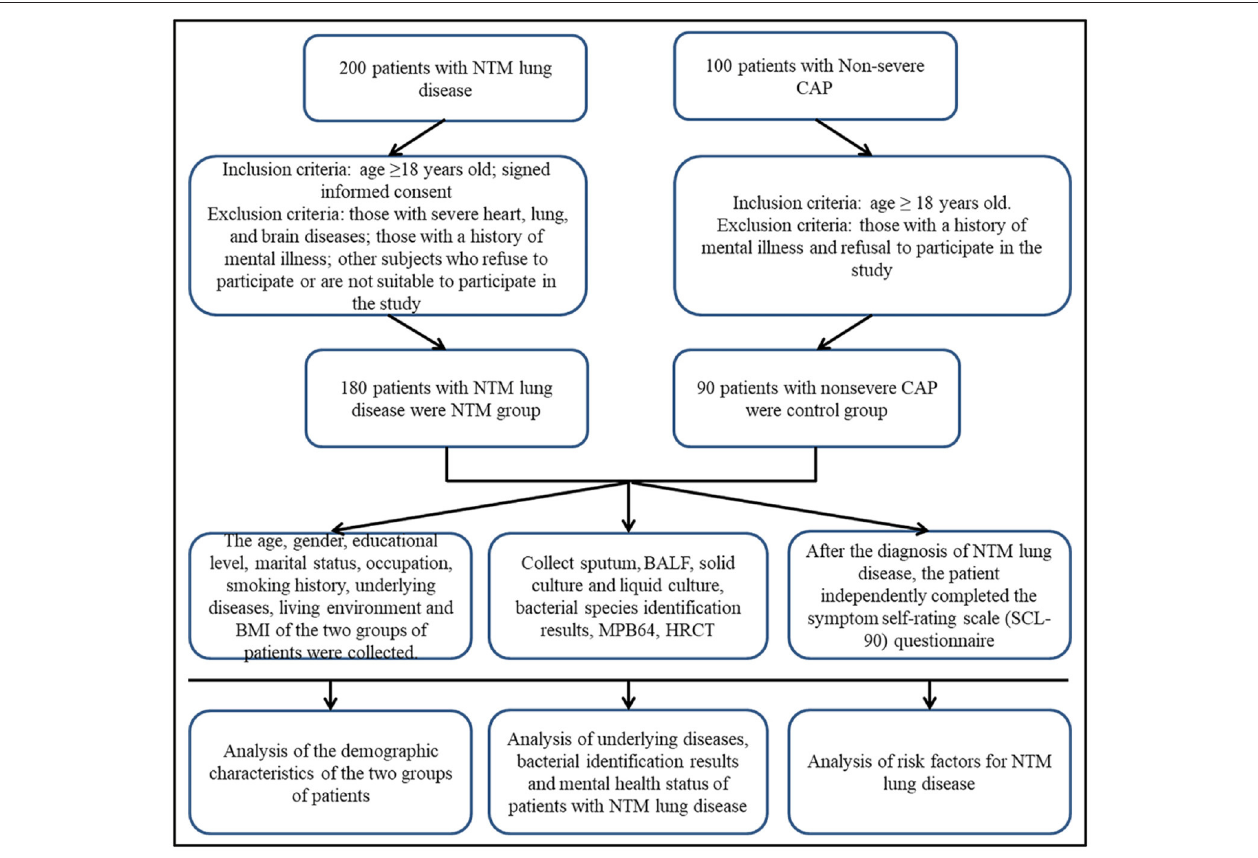
FIGURE 1 | Flow diagram of the study. NTM, non-tuberculous mycobacteria; CAP, community-acquired pneumonia; HRCT, High-resolution CT; BALF, bronchoalveolar lavage